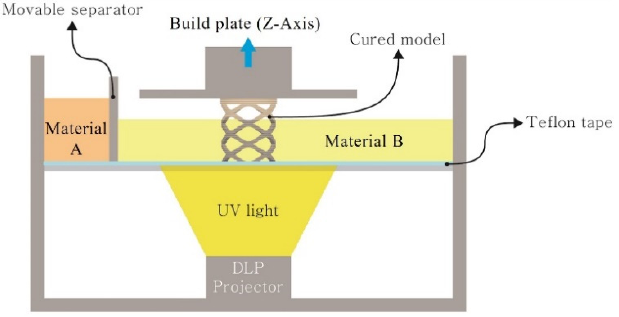
Figure 2. Conceptual diagram of the suggested printing equipment.